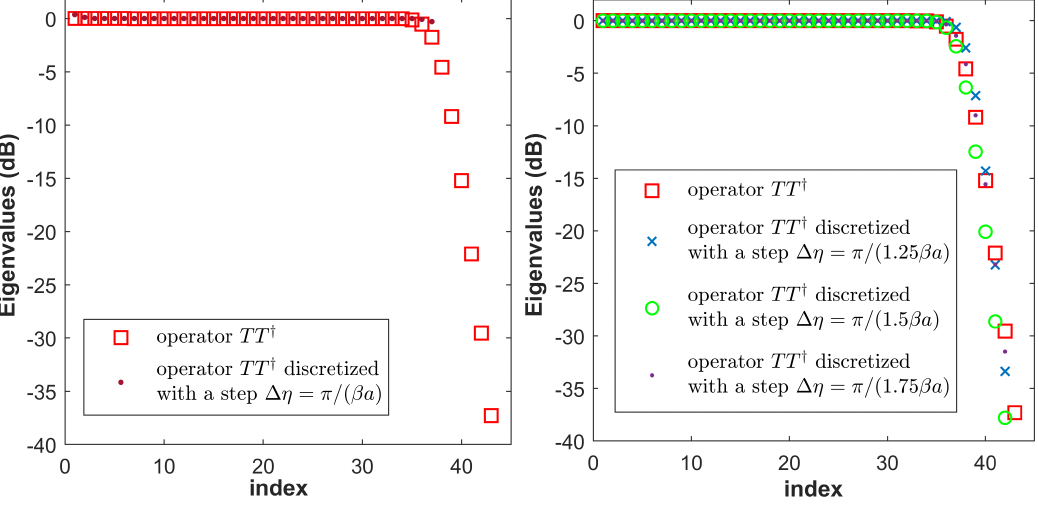
Figure 9. Eigenvalues of the operator T T † and those of its discrete version for different values of the sampling step ∆ η . The diagrams refer to the configuration a = 10 λ , z o = 5 λ , X o = 15 λ ( η ( X o ) =